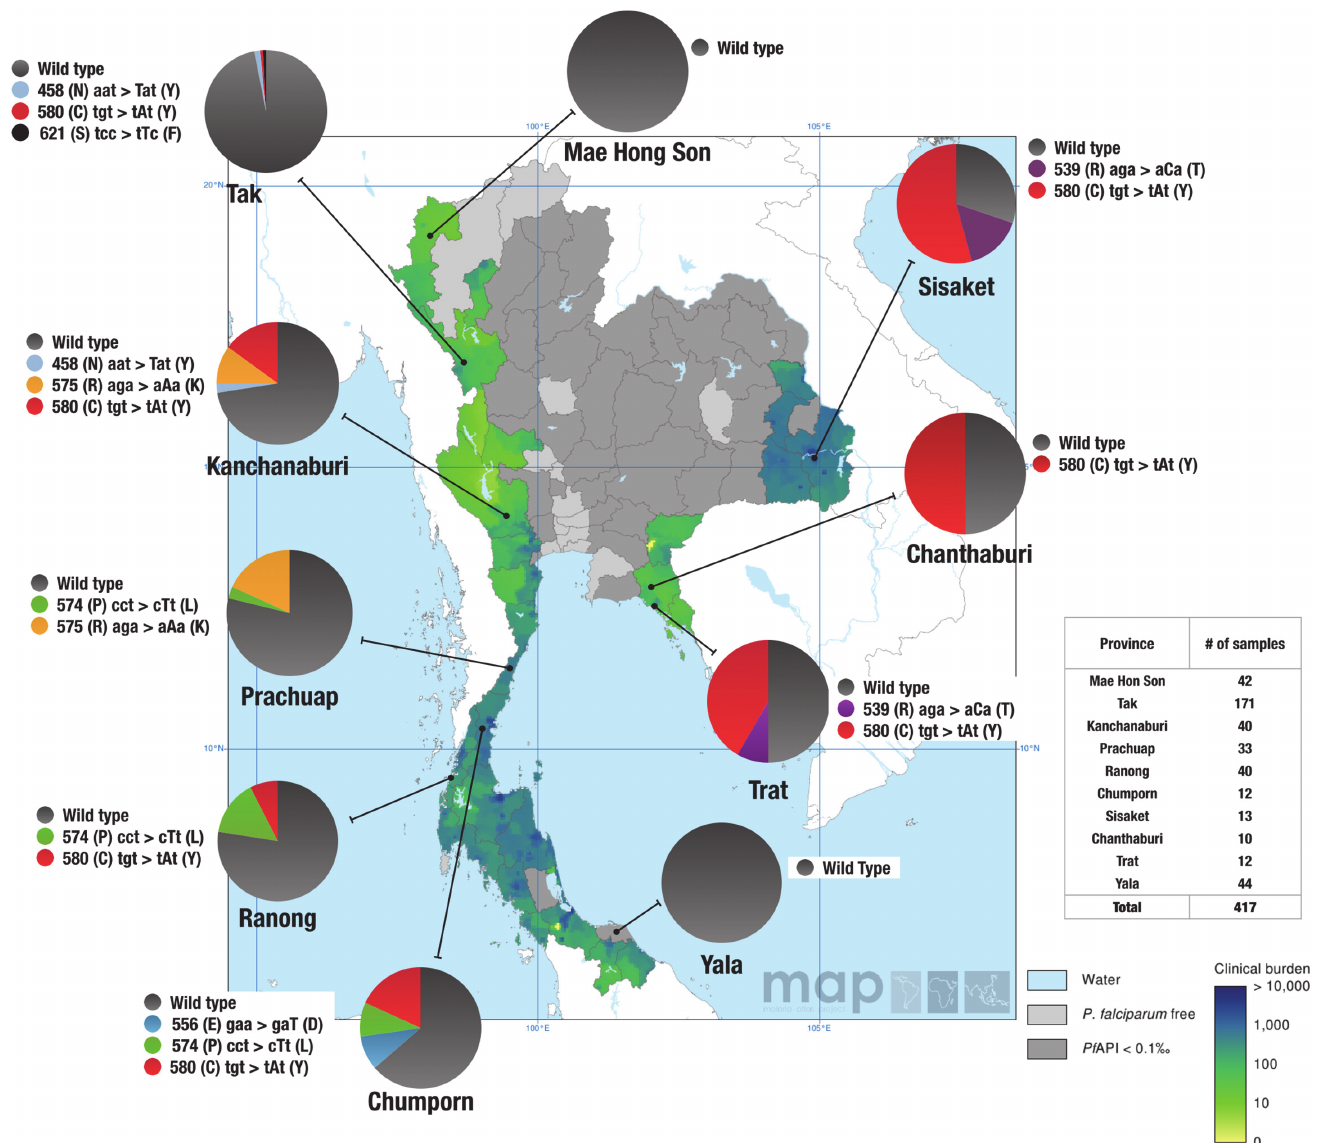
Fig 1. Geographic distribution of the K13 propeller alleles in Thailand in 2007. Pie charts show K13 propeller allele frequencies among 417 parasite isolates in 10 Thailand provinces. The different alleles are color coded. The results are shown on top of the clinical burden map of P . falciparum in Thailand in 2007 (Malaria Atlas Project) [34]. Light grey areas are P . falciparum malaria free and dark grey areas have an unstable risk of malaria transmission (i.e. annual case incidence, or API, is reported at less than 1 per 10,000). Map shows mean estimate for the clinical burden in the range from 0 (light green) to 10,000 (dark green/blue) clinical cases per year. The clinical burden predictions are based on a Bayesian geostatistical model.